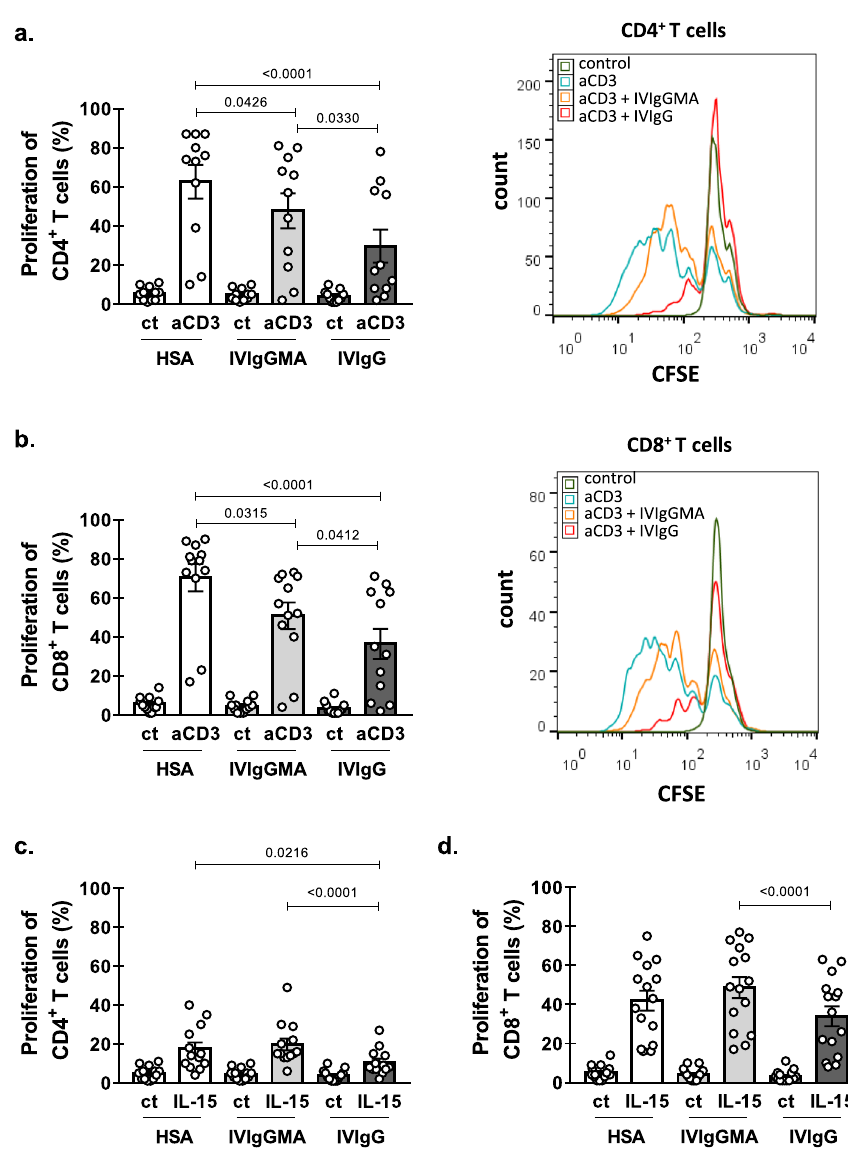
Figure 2. Effect of IVIg preparations on T cell proliferation. PBMC from CLL patients were labeled with CFSE and then cultured, in the presence of IVIgGMA, IVIgG (10 mg/mL of IgG) or HSA, in wells containing immobilized anti-CD3 mAbs (0.5 µg/mL) or the corresponding isotype control or IL-15 (20 ng/mL) as detailed in Materials and Methods. After 5 days, cells were collected, stained with specific mAb for CD4 and CD8 and proliferation was evaluated by flow cytometry. CFSE low cells were those that proliferated. ( a , b ) The figures show the percentage of CD4 + ( a ) and CD8 + ( b ) T cells that proliferated in response to TCR/CD3 stimulation. n = 11 for CD4 + T cells and n = 12 for CD8 + T cells. Individual values and the mean ± SEM are shown. Friedman test followed by Dunn’s post-test. Representative histograms are shown. ( c-d ) The figures show CD4 + ( c ) and CD8 + ( d ) cells that proliferated in response to IL-15. n = 13 for CD4 + T cells and n = 15 for CD8 + T cells. Individual values and the mean ± SEM are shown. Statistical analysis was performed using Friedman test followed by Dunn’s post-test. Significant p values are shown in the graph. p < 0.05 was considered